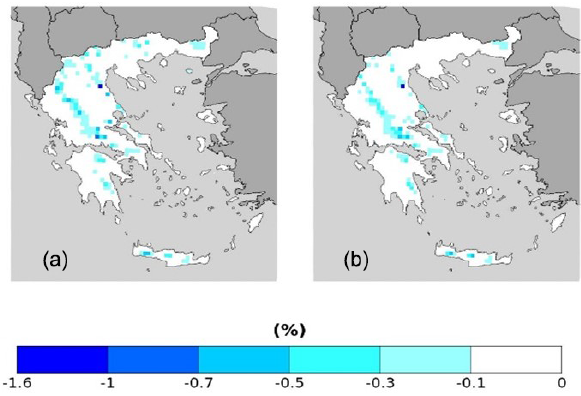
Figure 12. RR20ID empirical method probability differences of Table 9. Ensemble number of cells ( N c ) in each category of proba- bility difference (%) for RR20ID for empirical and copula method. MAX D denotes the maximum negative difference between future and past periods. N v concerns only cells with statistically signifi- cant difference. Empirical Empirical Copula Copula RCP4.5 RCP8.5 RCP4.5 RCP8.5